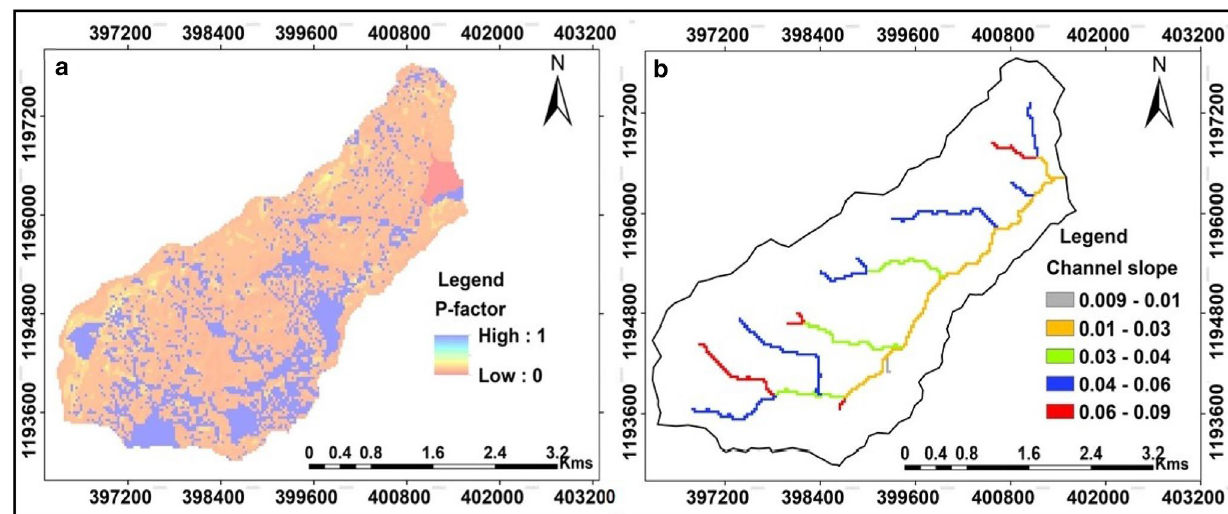
Fig. 5 P-factor ( a ) and channel slope ( b ) maps of the